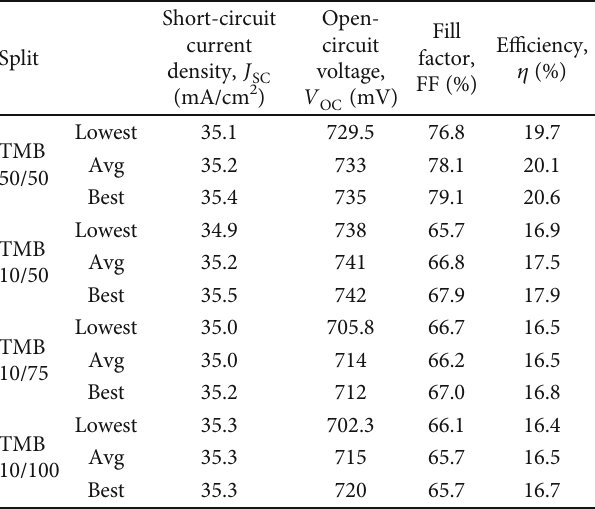
(a) Gas fl ow rates of silane ( Q the deposition of p-a-Si:H, and the corresponding fl ow ratios